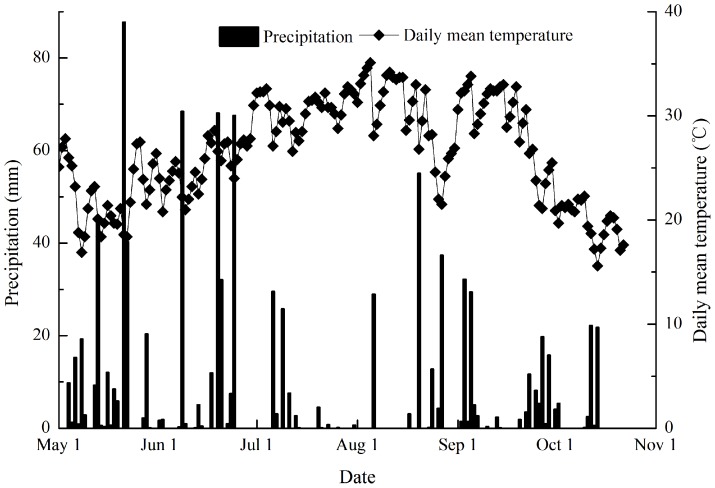
Daily precipitation and daily mean temperature at the study site during the experimental period.